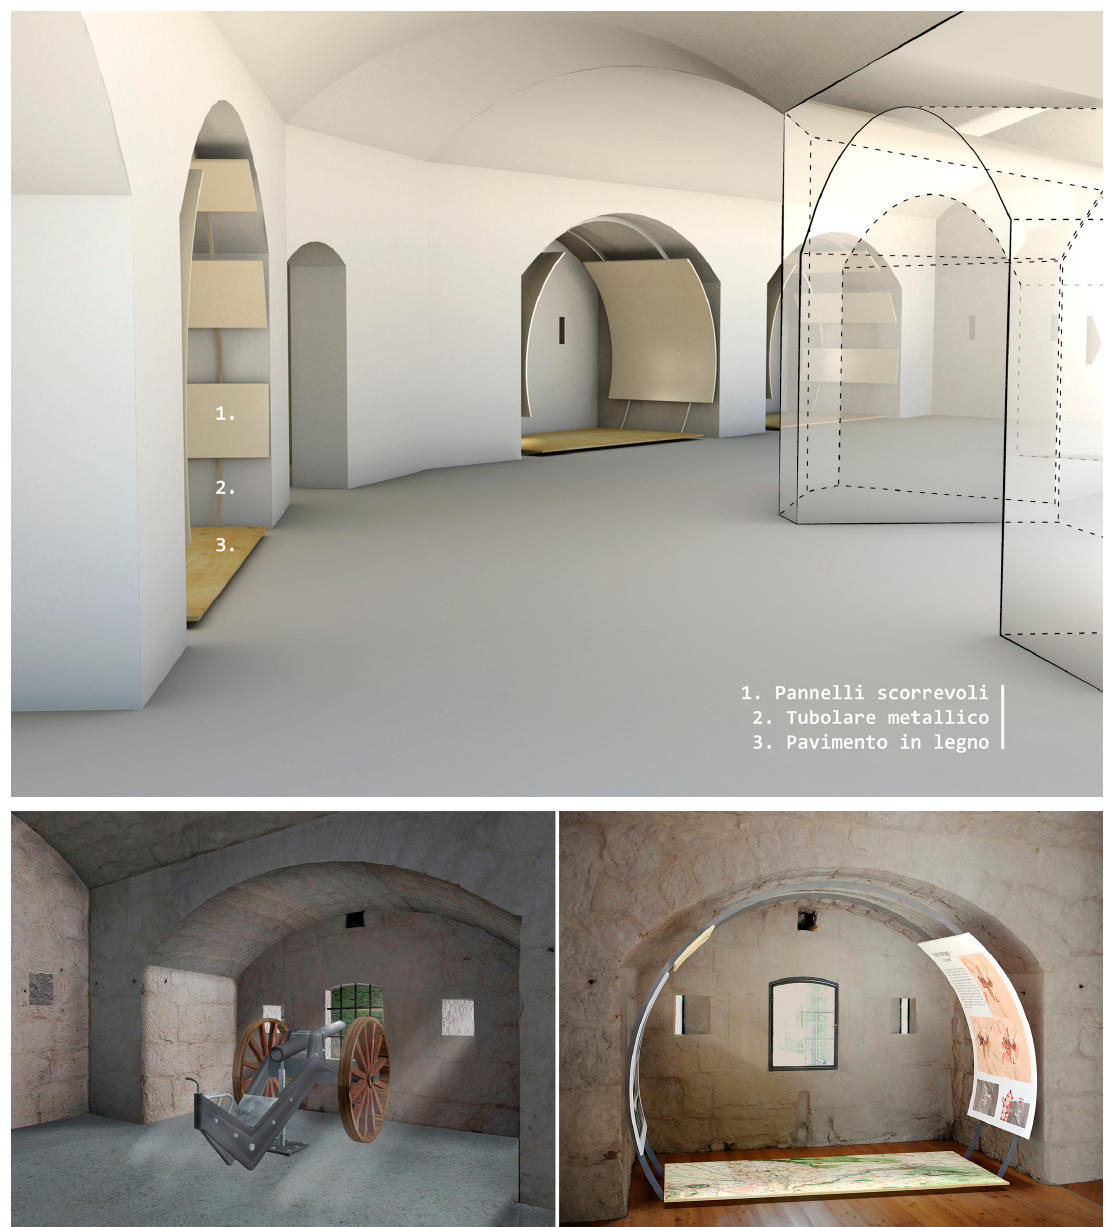
Figure 5. Above, the proposed exhibition design in the “casemate” of Roncogno Battery; down, the virtual reconstruction and design simulation of one of the cannons’